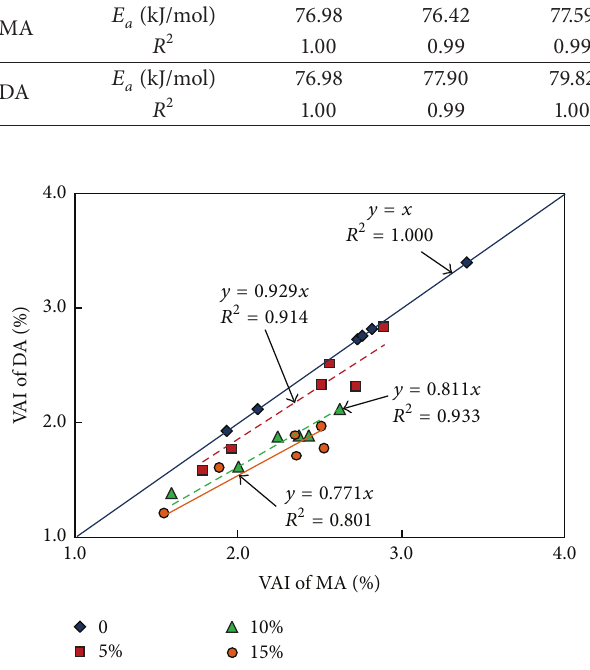
Figure 13: Comparative analysis of VAI.